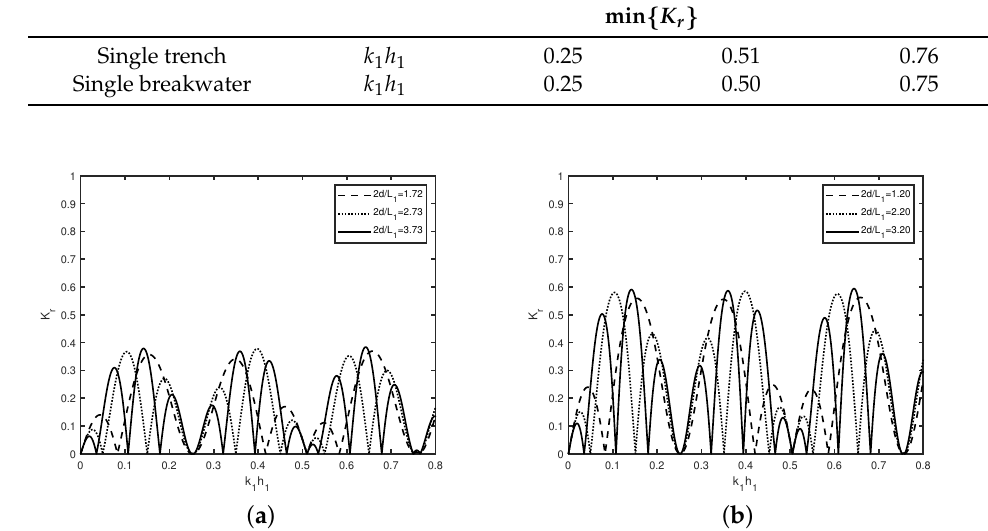
Table 4. Values of k 1 h 1 for common minimum of reflection coefficient for different values of w / L 1 .